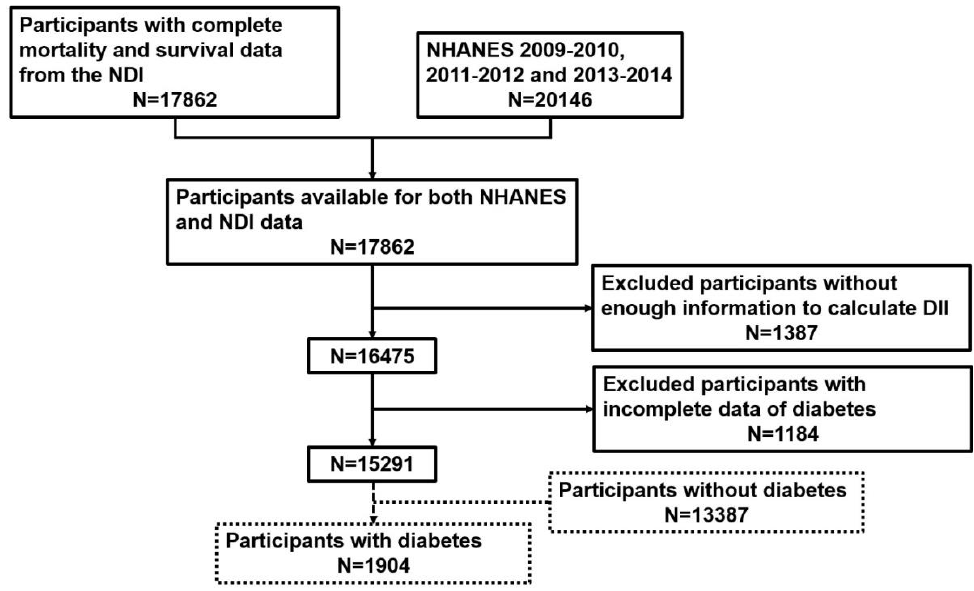
Figure 1. Flow chart of individual inclusion and exclusion.